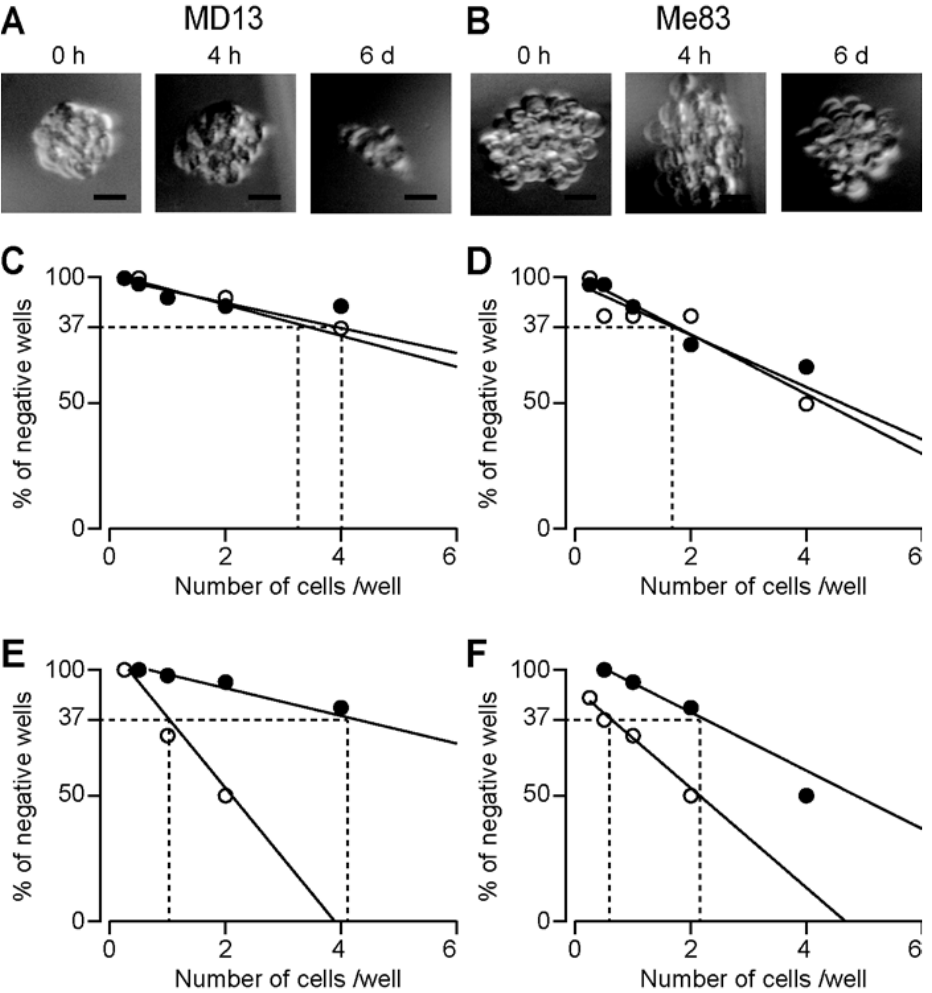
Figure 3. Limiting dilution sphere formation assay. Bars represent 50 µm. ( A , B ) Sphere clumps at 6 d after treatment with 2% sevoflurane for 0 h, 4 h, or 6 d. ( C ) Open and filled circles represent MD13 cells treated with 2% sevoflurane for 0 and 4 h, respectively. ( D ) Open and filled circles represent Me83 treatment with 2% sevoflurane for 0 and 4 h, respectively. ( E ) Open and filled circles represent MD13 treatment with 2% sevoflurane for 0 h and 6 days, respectively. ( F ) Open and filled circles represent Me83 treatment with 2% sevoflurane for 0 h and 6 days, respectively. The number of wells without spheres was counted and plotted against the number of cells per well.